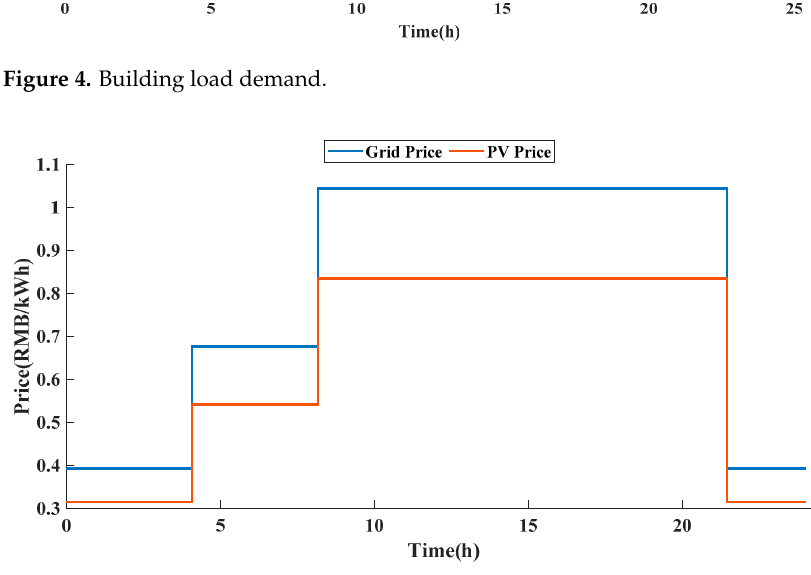
Figure 5. TOU Price.